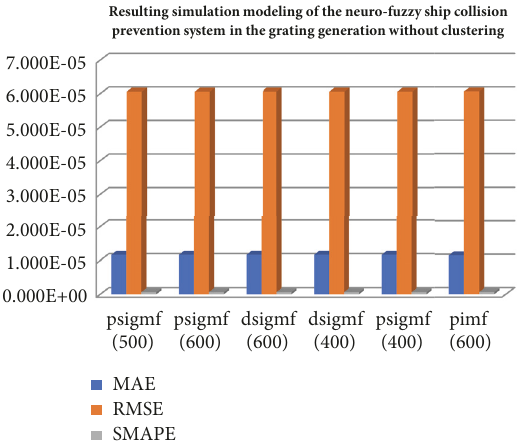
Figure 3: Resulting qualitative evaluation in the neural-fuzzy ship collision prevention system training in the generation by the lattice method without